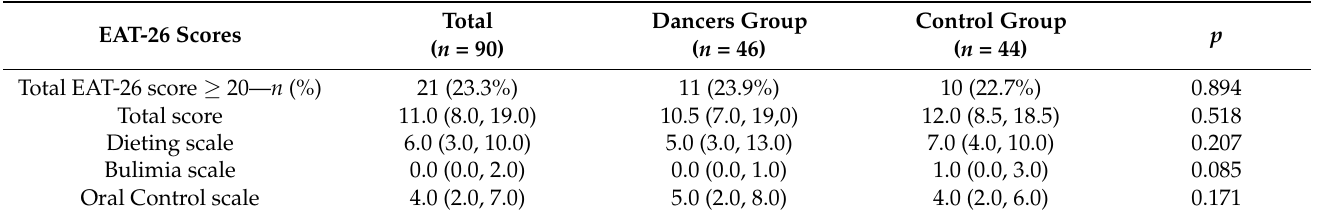
Table 4. Participants’ scores in EAT-26 (median and IQR) and count of participants that scored ≥ 20.